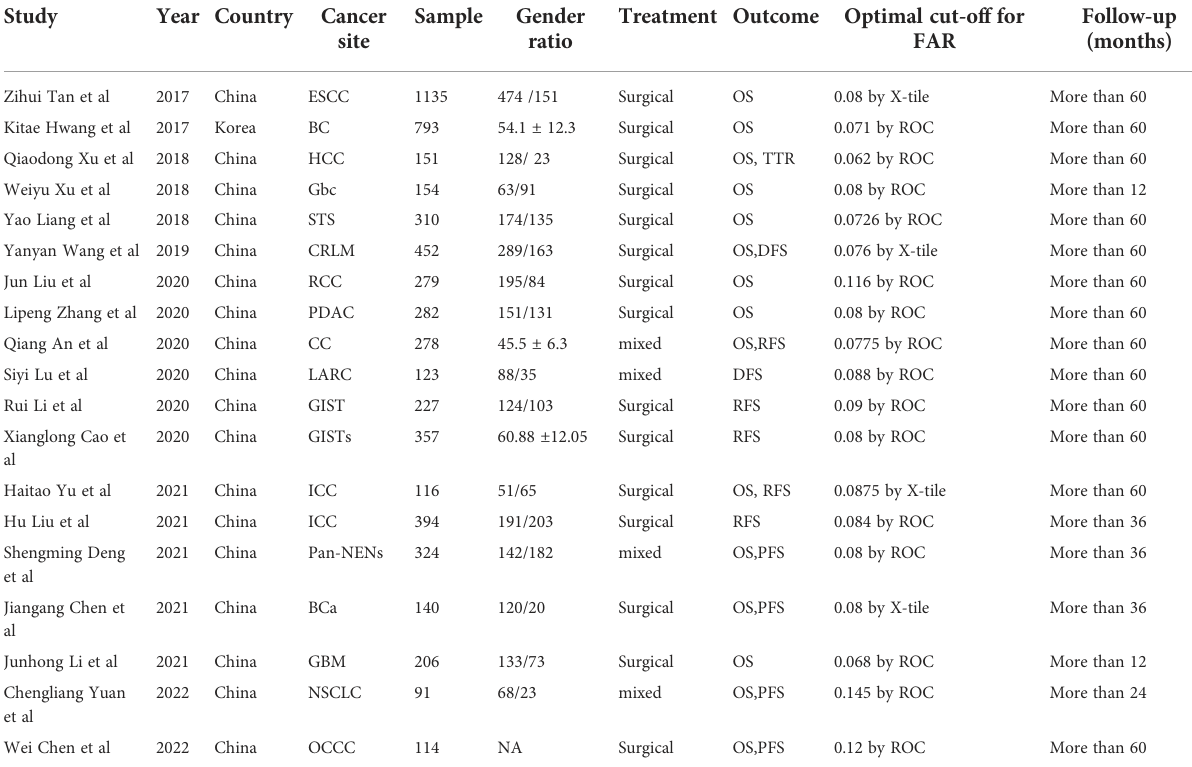
TABLE 1 The characteristics of included